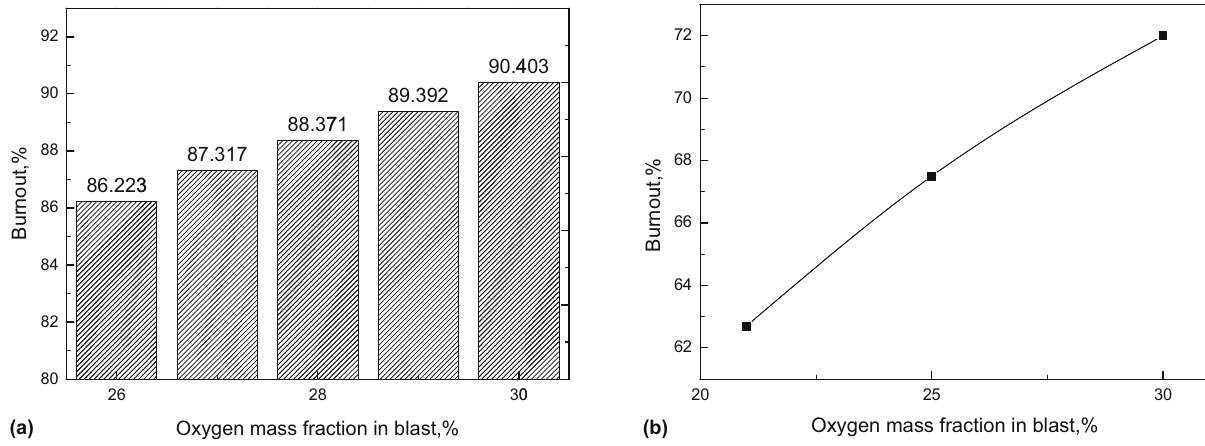
Figure 5: E ff ect of oxygen mass fraction in the hot blast on pulverized coal burnout: ( a ) the results of this paper ( the common grid ) and ( b ) literature results.